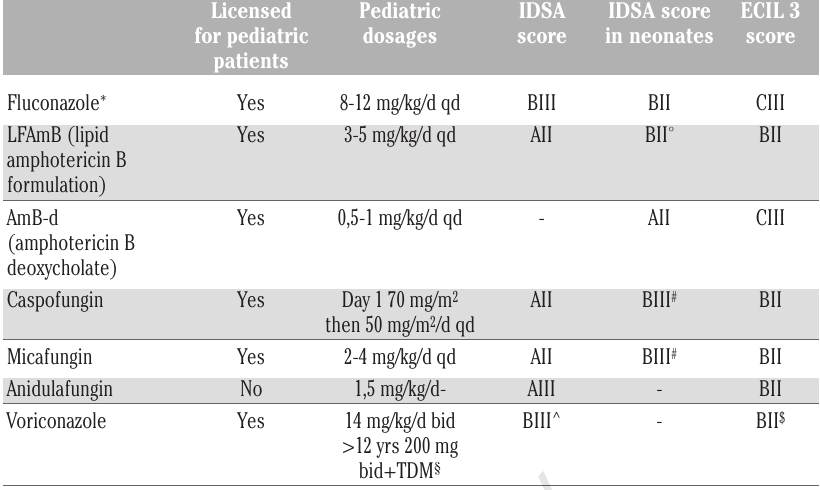
Table 1. Pediatric dosages and grade of recommendation of different antifungals for neu- tropenic